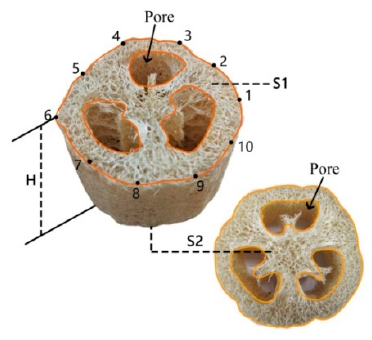
Figure 1. Locations of the 10 height test points of luffa cylinder.